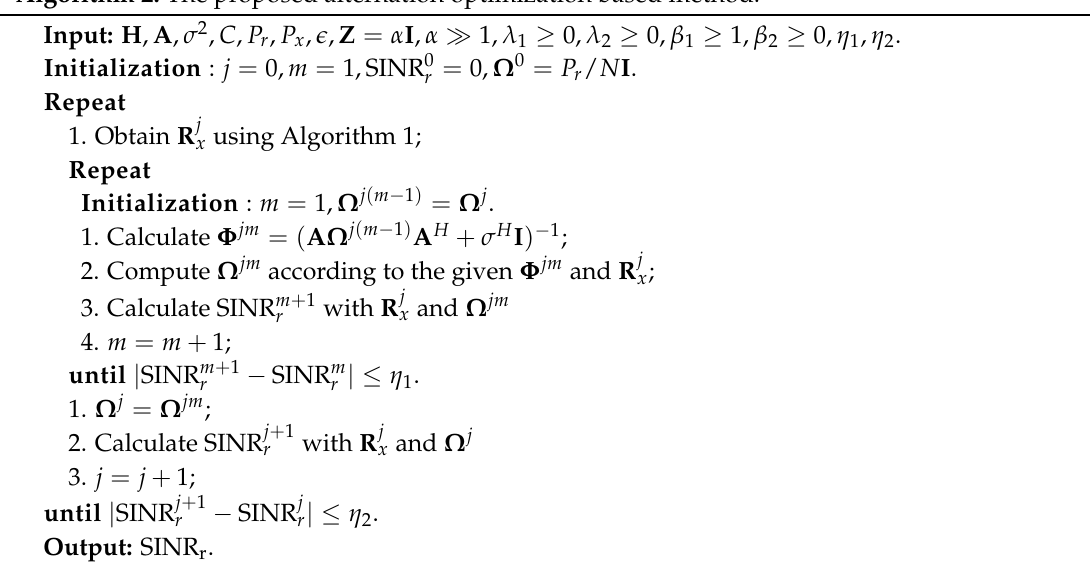
Algorithm 2: The proposed alternation optimization based